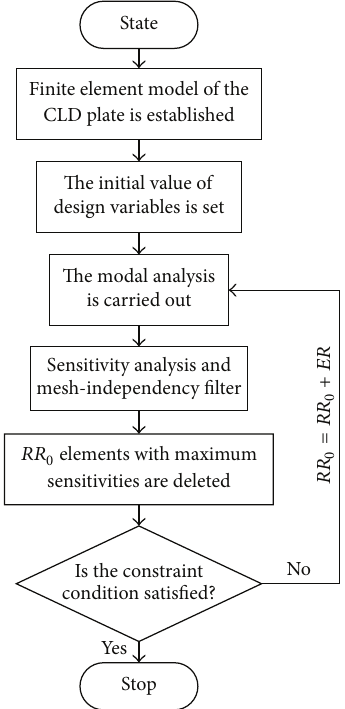
Figure 2: Flowchart of the topology